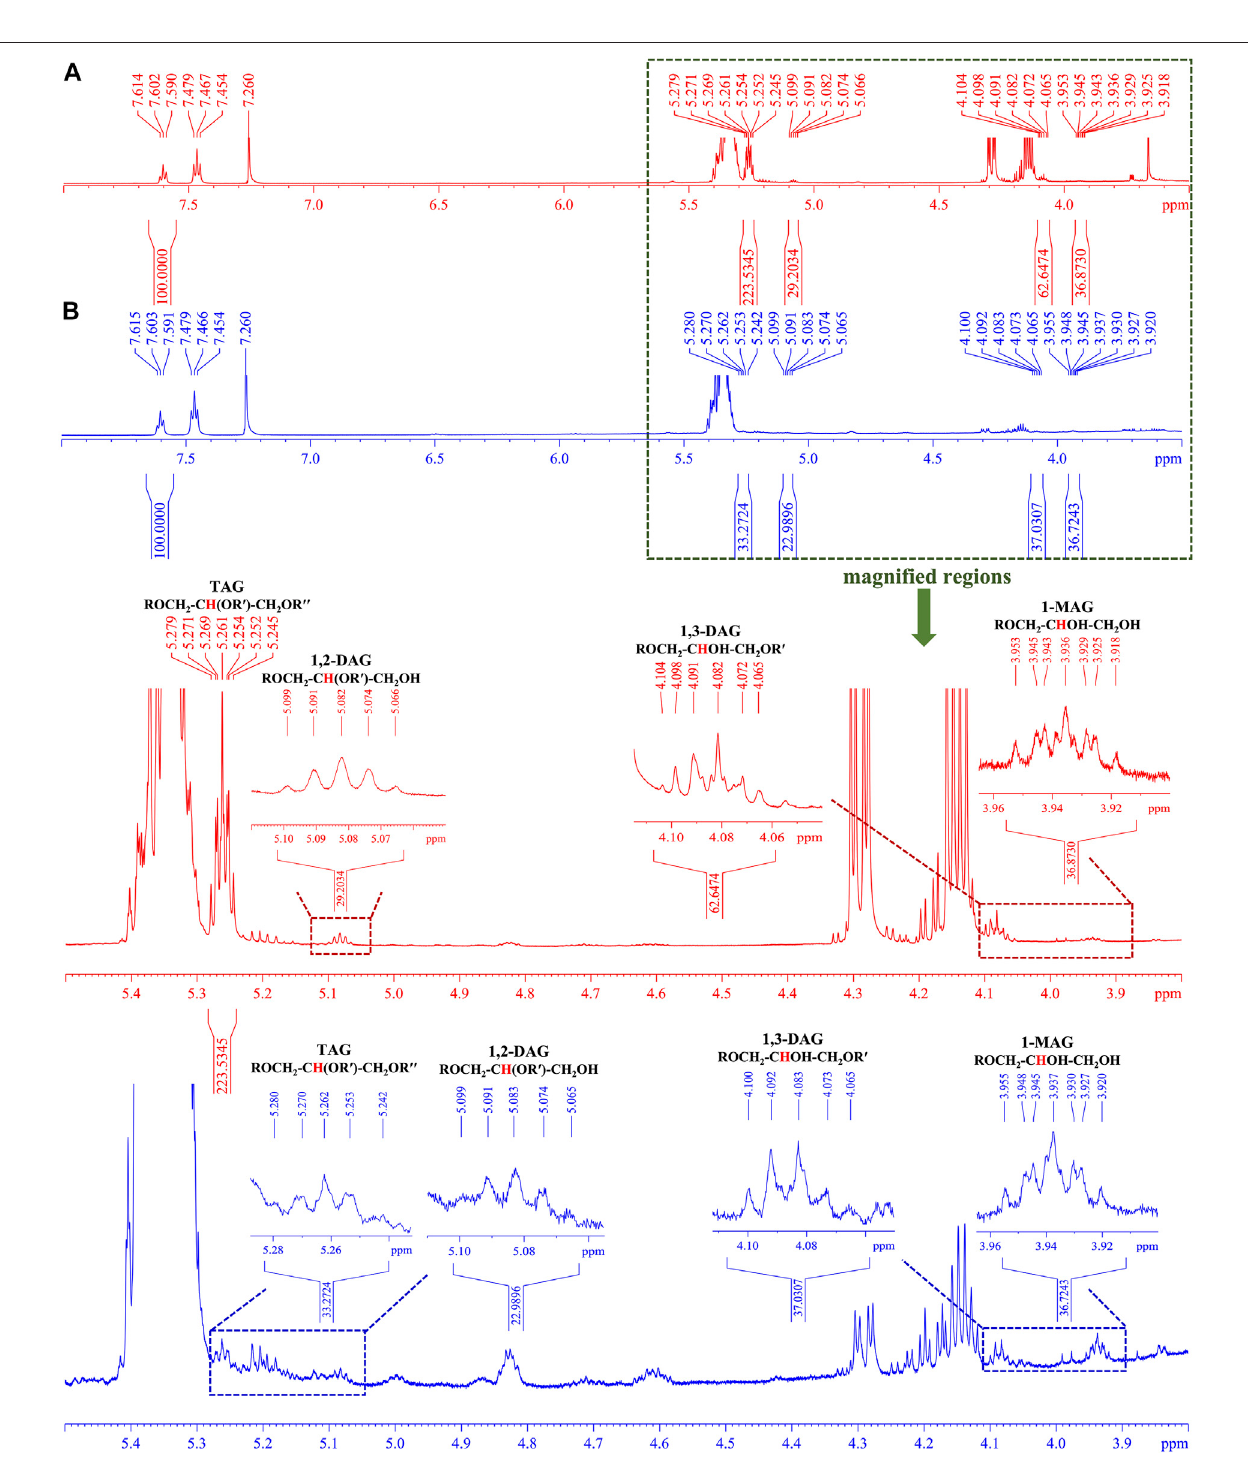
FIGURE 6 | The representative 1 H-NMR spectra (600 MHz) ofcultured and natural C. sinensis in CDCl 3 (A,B) : CCS sample (No. 2 in red) and NCS (No. 17 in blue) showing the range of chemical shift ( δ ) from 8.0 to 3.5 ppm, respectively. The tertiary protons at sn -2 position of detected glycerides were assigned in the magni fi ed regions ranging from 5.5 ppm to 3.8 ppm.